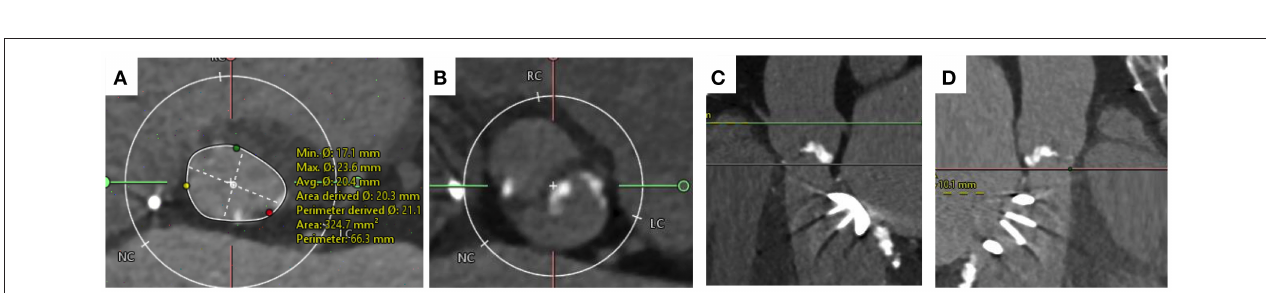
FIGURE 5 | MSCT imaging of bicuspid aortic valve. (A) Annulus measurement with minimum diameter of 17mm and maximum diameter of 24mm and area of 325 mm 2 . (B) Cross-sectional view taken 4mm above the level of the annulus. The valve is a Type 0 Sievers BAV with no raphe. (C) Distance to coronary ostia > 10mm. (D) The distance from the aortic annulus to the mitral valve ring measures 10.1mm acceptable for TAVI implantation.